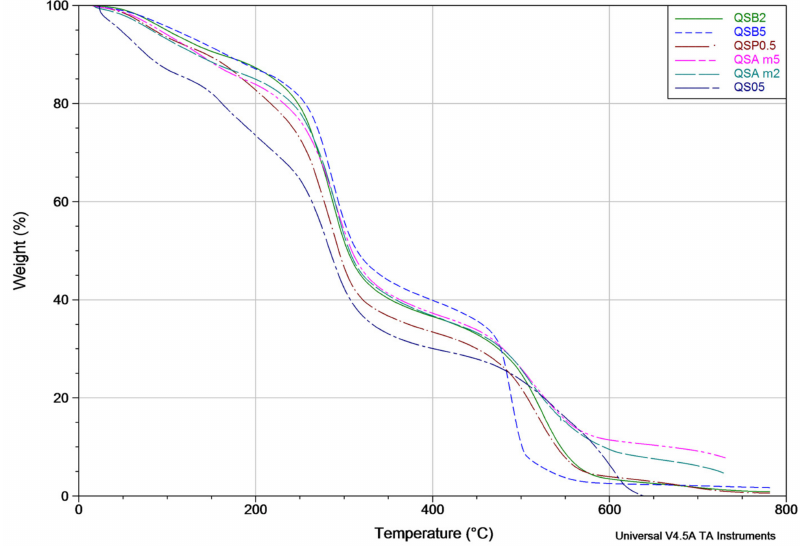
Figure 10. Thermograms of QSAm2, QSAm5, QSB2, QSB5 and QSO5